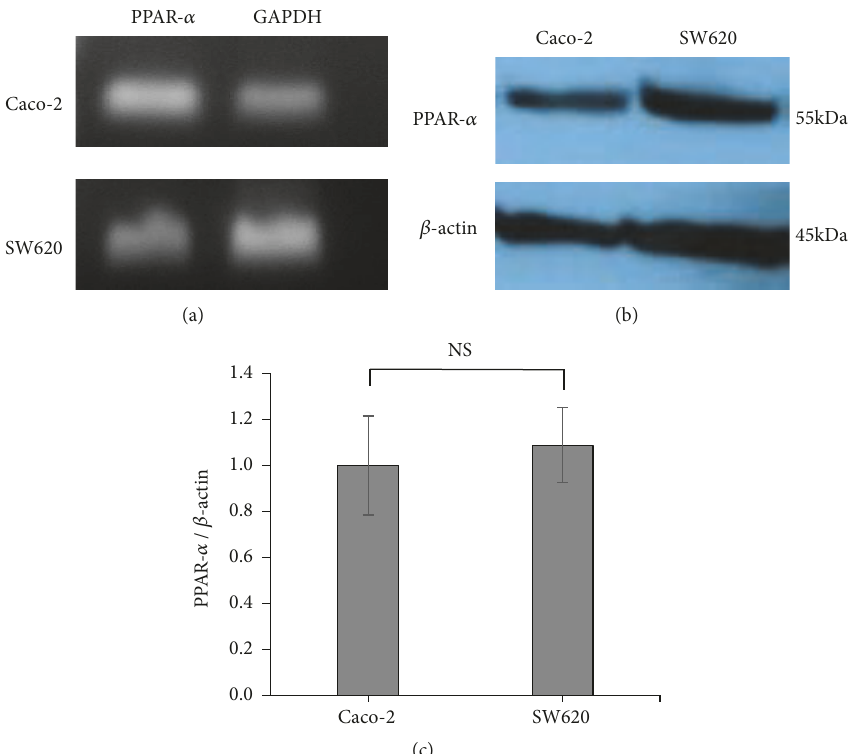
Figure 1: PPAR- 𝛼 mRNA and protein are expressed in colorectal carcinoma cells. (a) RT-PCR analysis of PPAR- 𝛼 in Caco-2 and SW620 cells. (b) PPAR- 𝛼 protein was assayed by western blot in Caco-2 and SW620 cells. (c) PPAR- 𝛼 protein levels were calculated and compared with those of Caco-2 and SW620 cells. Error bars indicate standard deviation.